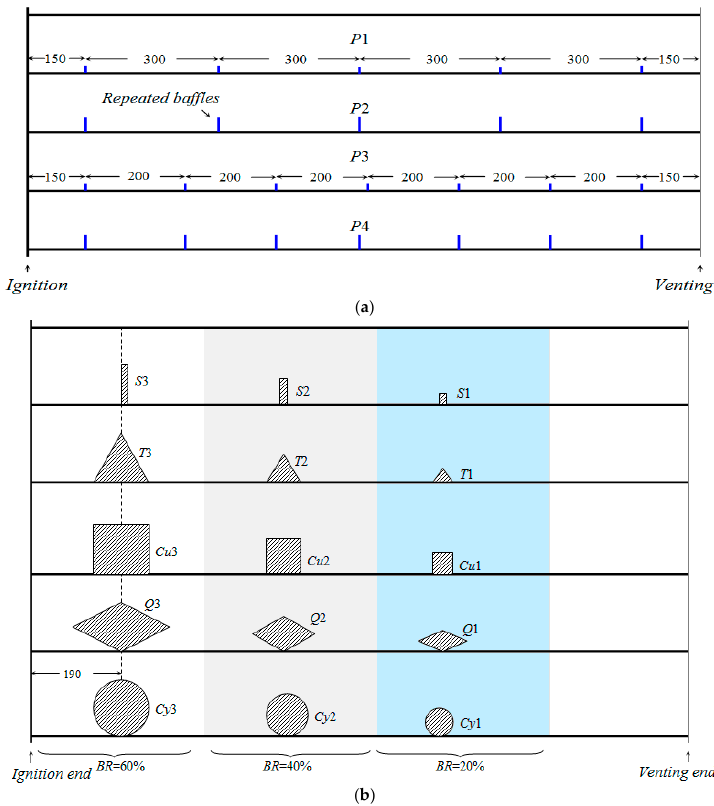
Figure 3. Arrangement methods for various obstacles: ( a ) planar type repeated baffles; and ( b ) solid structure obstacles. Table1. Obstacle types used in the experiments.